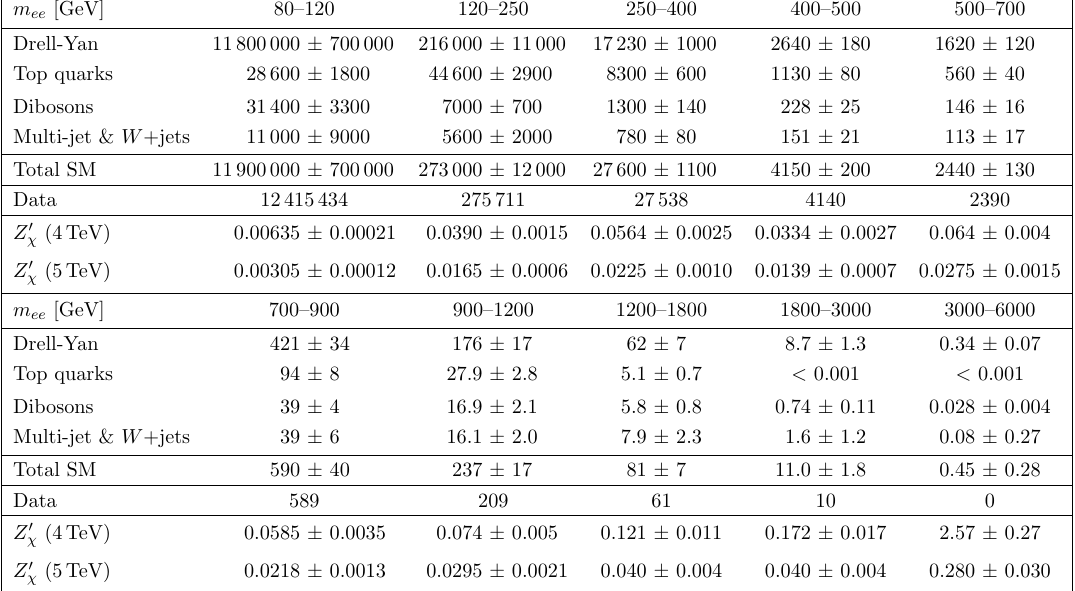
Table 3 . Expected and observed event yields in the dielectron channel in di(cid:11)erent dilepton mass intervals. The quoted errors correspond to the combined statistical, theoretical, and experimental systematic uncertainties. Expected event yields are reported for the Z 0 the pole mass. All numbers shown are obtained before the marginalisation